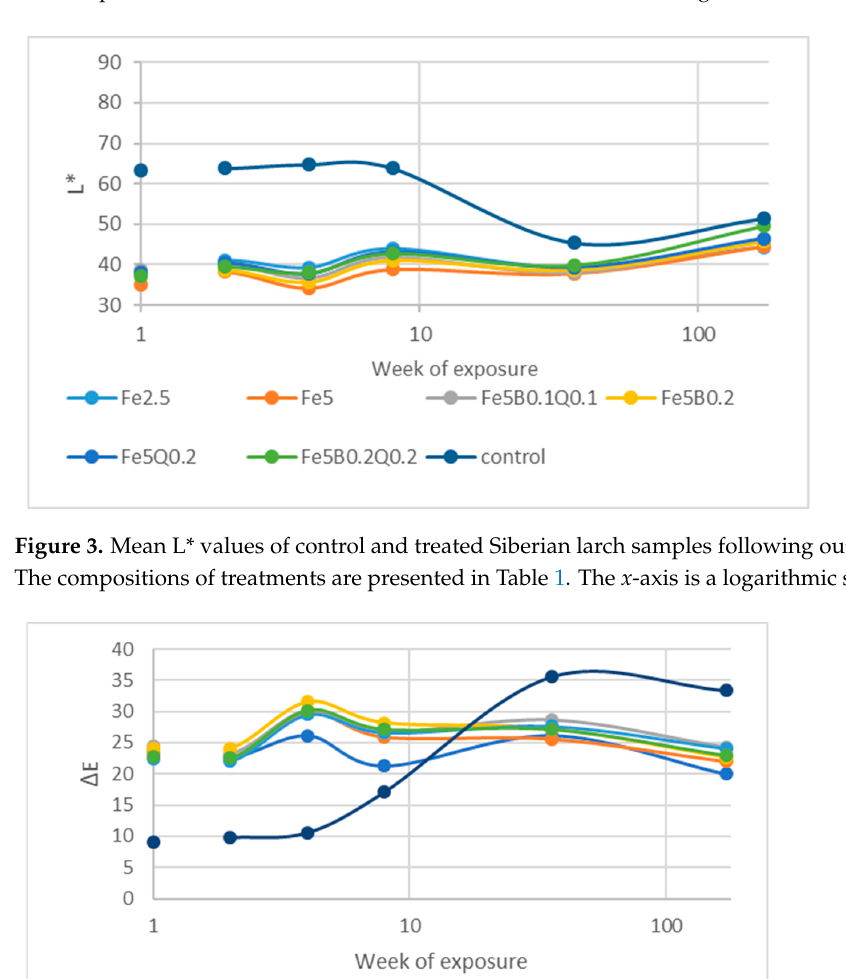
Figure 5. Mean colour change ( Δ E) of control and treated Siberian larch samples following outdoor exposure. The compositions of treatments are presented in Table 1. The x -axis is a logarithmic scale.